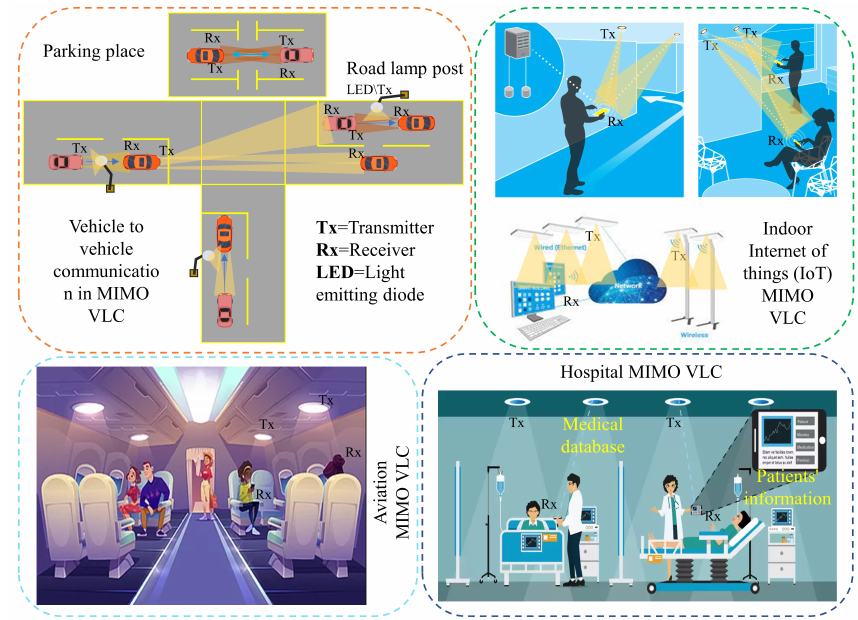
Figure 1. Overview of the VLC-based MIMO communication